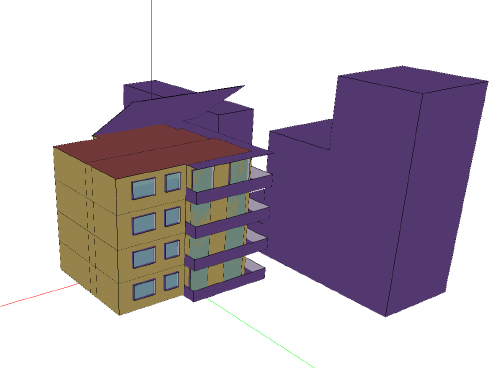
Figure A1. Envelope visualization for the Apartments and Apartments2 buildings. The difference between Apartments and Apartments2 lies in their thermal